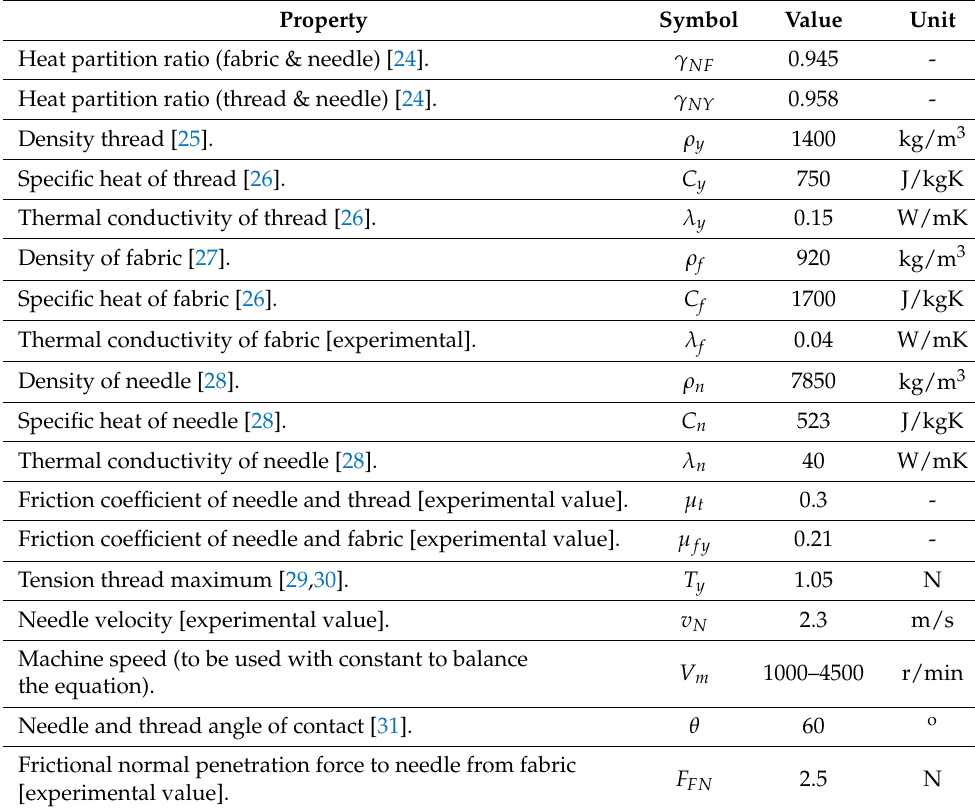
Table 3. Legend of equations. γ NY Partition ratio of heat gain between needle and thread using Charron’s relation. γ FN Partition ratio of heat gain between needle and fabric using Charron’s relation. µ YN Coefficient of friction between needle and sewing thread. µ FN Coefficient of friction between fabric and sewing thread. T y Maximum tension of sewing thread during sewing cycle. θ Angle of sewing thread with respect to the needle. v FN Velocity of needle with respect to the fabric. F FN Needle penetration force with respect to the fabric. v YN Velocity of thread with respect to the needle. Table 4. List of symbol and units. Property Symbol Value Unit Heat partition ratio (fabric & needle)